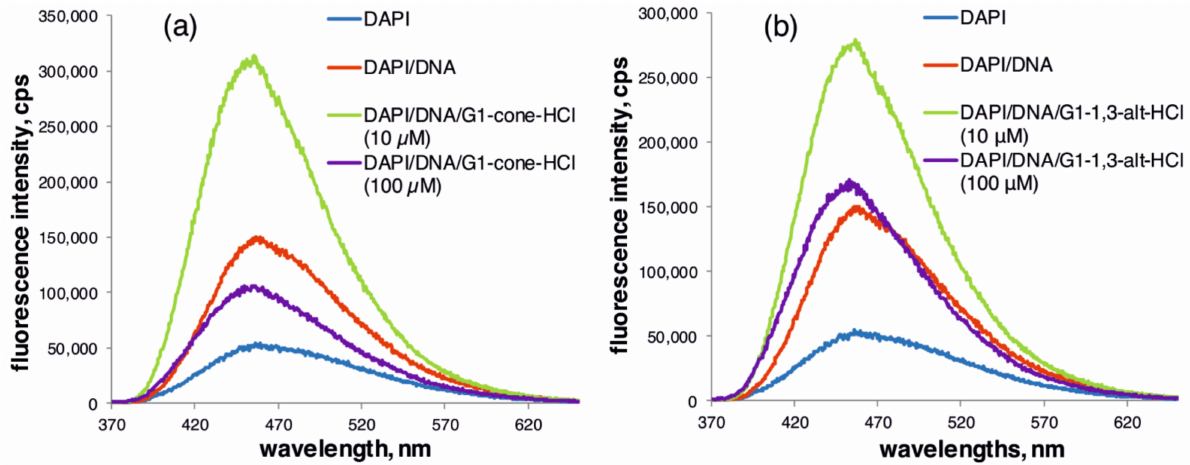
Figure 4. Fluorescence spectra of DAPI (1 × 10 − 5 M), DAPI/DNA (5.565 × 10 − 5 M base pairs) and DAPI/DNA in the presence of 10 µ M and 100 µ M of: ( a ) G1-cone-HCl and ( b ) G1-1,3-alt-HCl , in 10 mM Tris-HCl buffer, pH =